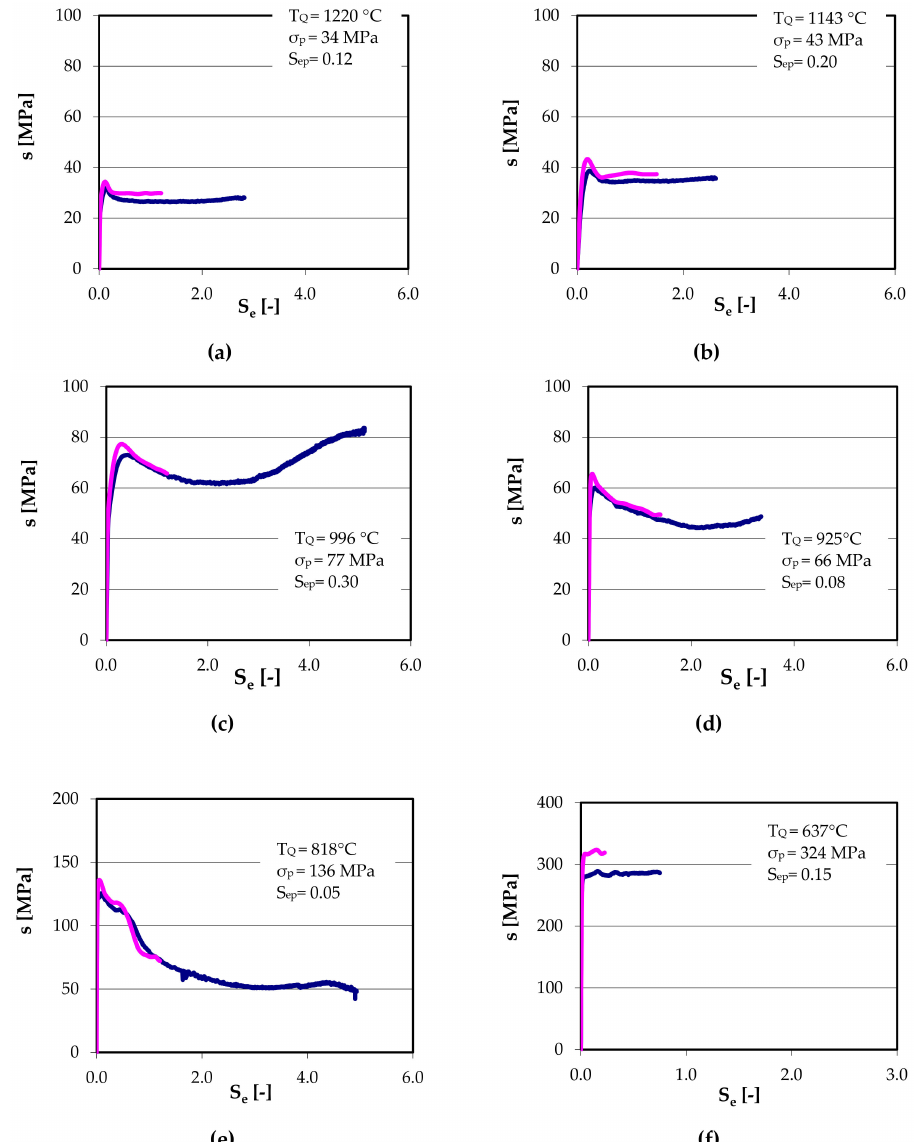
Figure 2. Dependence of stress σ on deformation intensity S e at selected temperatures: ( a ) T Q = 1220 ◦ C, N f = 45.6, sample X3; ( b ) T Q = 1143 ◦ C, N f = 38, sample X9; ( c ) T Q = 996 ◦ C, N f = 326.8, sample V9; ( d ) T Q = 925 ◦ C, N f = 72.8, sample X6; ( e ) T Q = 818 ◦ C, N f = 284.4, sample V5; ( f ) T Q = 637 ◦ C, N f = 5.5, sample V1; (pink curve–with parameter, blue curve–without parameter; S ep –peak intensity of deformation, σ p -peak